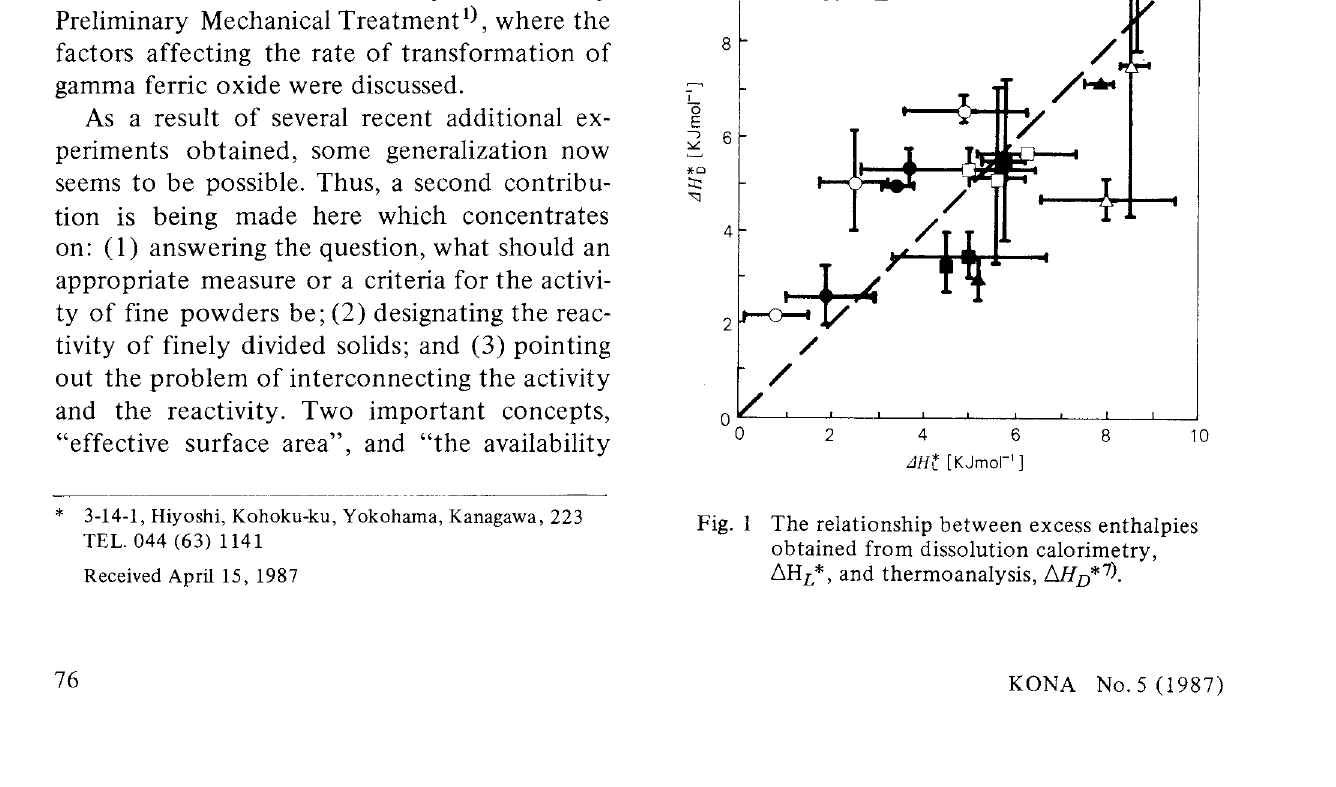
Fig. 1 The relationship between excess enthalpies obtained from dissolution calorimetry, !:::.HL*, and thermoanalysis, I::Ji D*7).